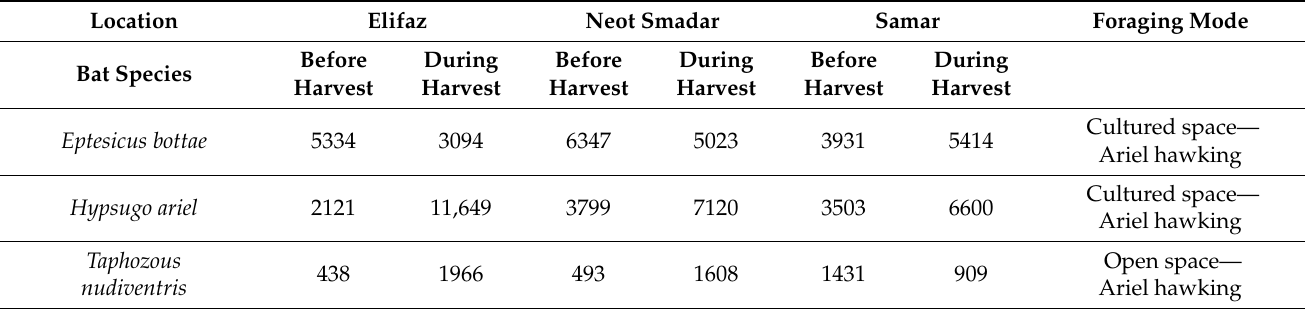
Table 1. Total bat passes per species and their foraging mode in three date plantations located